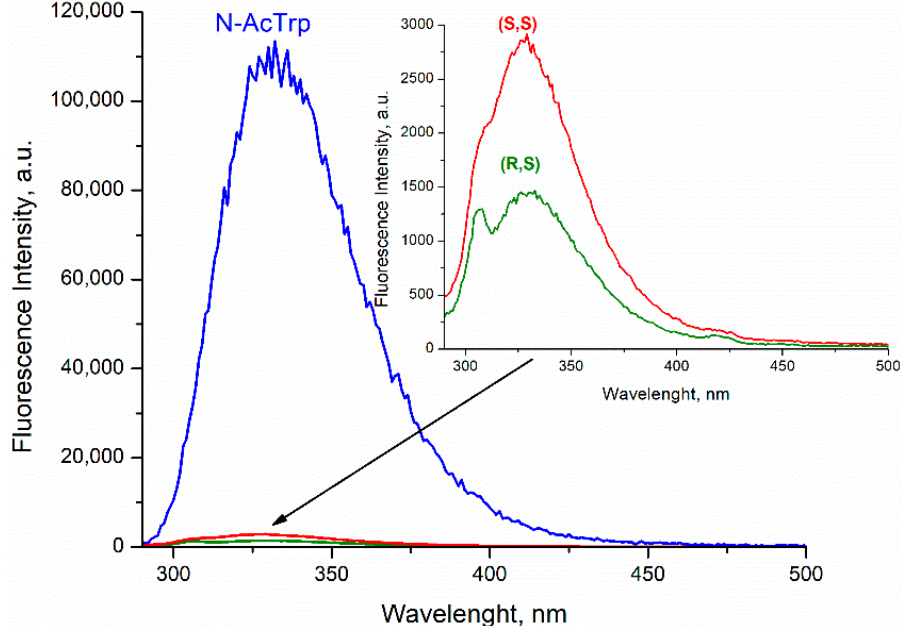
Figure 3. The corrected fluorescence emission spectra of KP-Trp dyad compared to the parent N-acetyl-tryptophan methyl ester in acetonitrile, λ exc = 280 nm. Such low fluorescence quantum yield was accounted for concurrent SSET and ET (Scheme